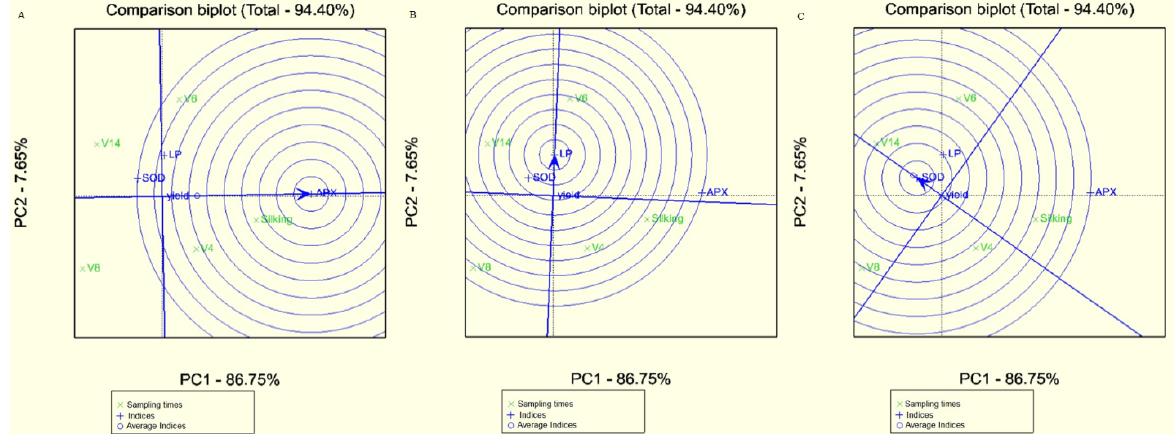
Figure 5. Biplot of the sampling times effect on ( A ): ascorbate peroxidase (APX), ( B ): the lipid peroxidation (LP), and ( C ): superoxide dismutase (SOD) (N = 1785).